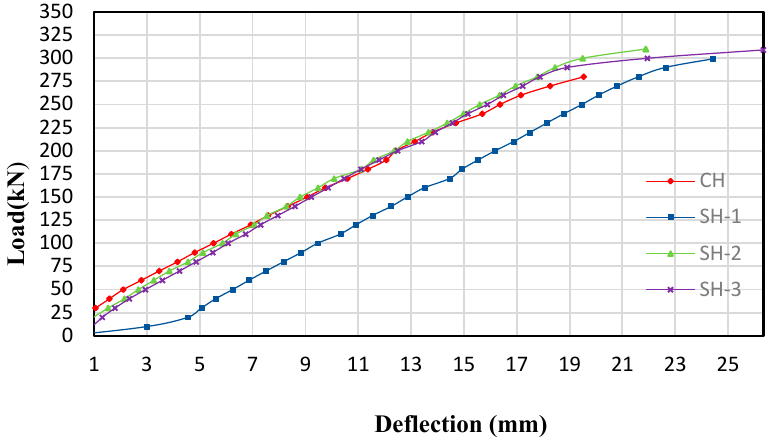
Figure 6. Load–deflection curve for beams of group H. For group M, all strengthened beams showed a noticeable increase in the ultimate load capacity compared to the reference beam (CM) by 35.67%, 22.29%, and 30.0% for (SM-1), (SM-2), and (SM-3), respectively. Figure 7 shows the load and deflection curves for all group specimens. The highest ultimate load was achieved in specimen (SM-1), and thus it is considered the best-strengthened scheme within this group, followed by (SM-3), and finally (SM-2). Moreover, all beams showed an increase in the vertical deflection compared to the control beam (CM), thus, indicating that strengthening using CFRPs strips in this group enhanced the ductility behavior. (SM-3) showed the highest ductility behavior compared to all strengthened schemes.